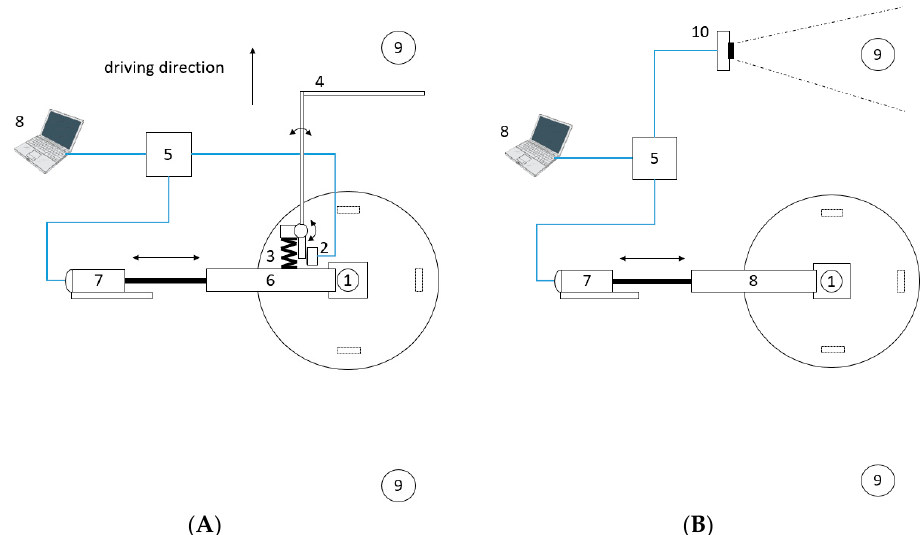
Figure 3. The two different control methods: ( A ) Feeler controlled unit and ( B ) Sonar sensor controlled actuator for the developed autonomous electric weeder. 1–Electric weeder; 2–Switch; 3–Spring; 4–Feeler; 5–Embedded controller; 6–Bar for implement; 7–Linear actuator; 8–PC; 9–Trunks (poles); 10–Sonar sensor.